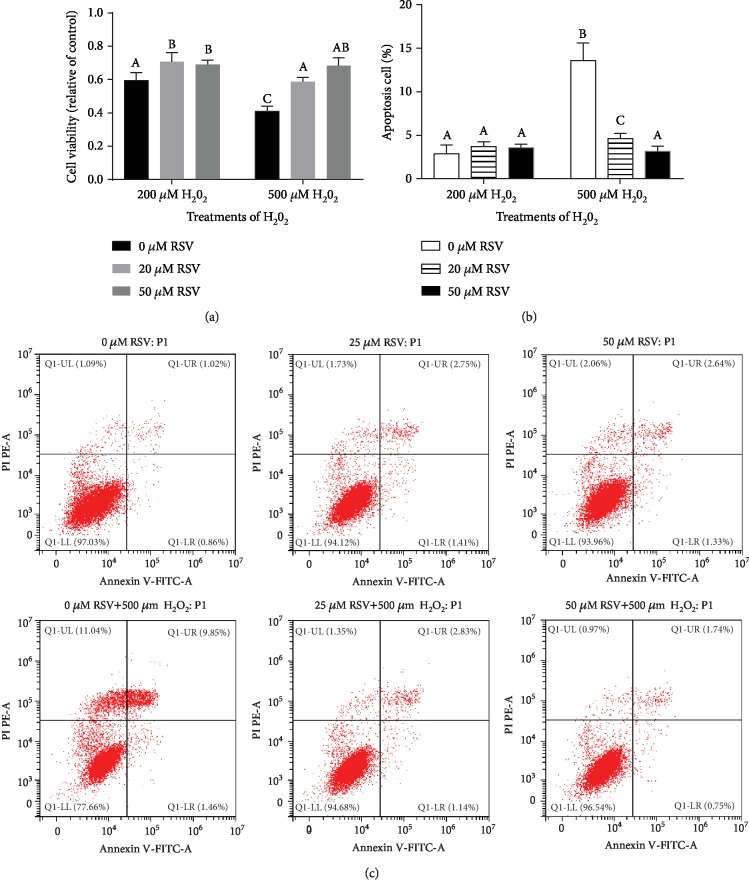
Protective effects of RSV against H2O2-induced oxidative injury in IPEC-J2 cells. IPEC-J2 cells were pretreated with the indicated concentrations of RSV and then cocultured with 200 μM or 500 μM H2O2 for 4 hours. (a) The CCK-8 assay was performed on IPEC-J2 cells after incubation with RSV (6 h) and H2O2 (4 h). (b, c) Apoptosis cells were analyzed by flow cytometry using Annexin V and propidium iodide (PI) double staining. Results are presented as the percentage of cell viability compared with the control (0 μM). Values are the mean ± SE. The columns with the same superscript capital letters and with different superscript capital letters mean no significant difference (P > 0.05) and significant difference (P < 0.05), respectively.